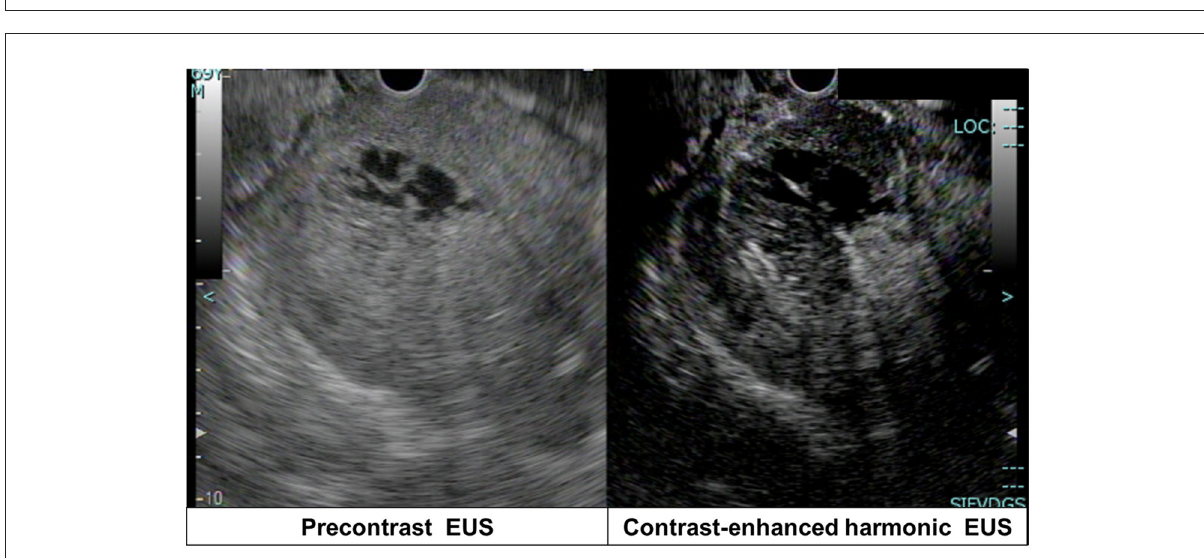
FIGURE4 Contrast-enhanced harmonic endoscopic ultrasonography shows mixed hypo-/non-enhancement patterns in the pancreatic tail mass solid components.